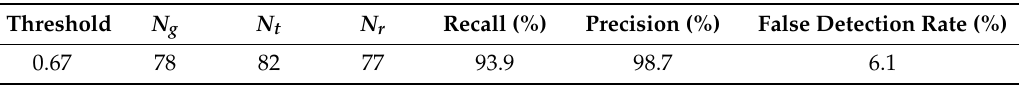
Table 2. Recall, precision and false detection rate from the detection result of the test Kompsat-5